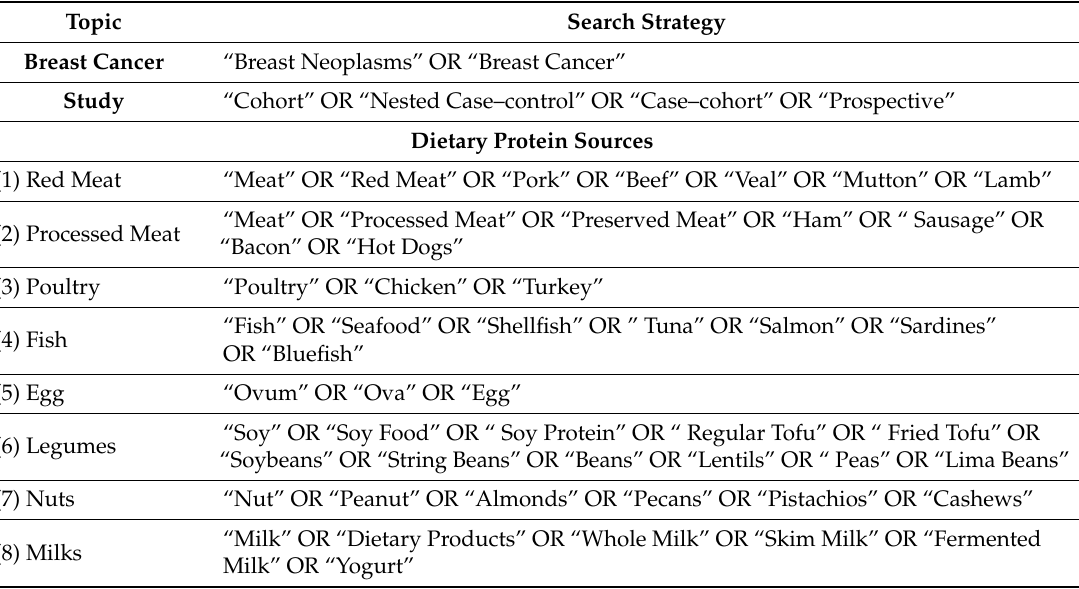
Table 1. Search Strategies for